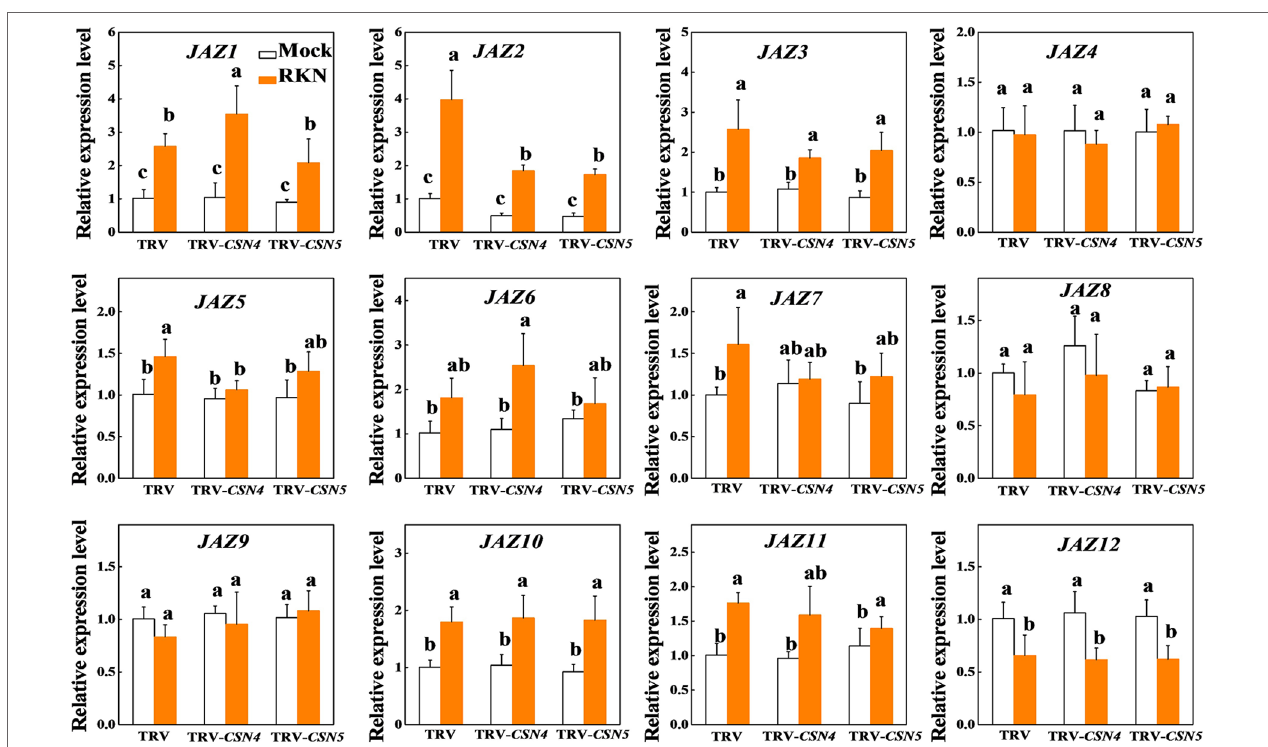
FIGURE 7 | The expression of JAZ genes in tomato roots 24 h after infection with Meloidogyne incognita . The data shown are the average of three biological replicates, with the standard errors shown by vertical bars. Means denoted by the same letter did not significantly differ at P < 0.05, according to Tukey’s